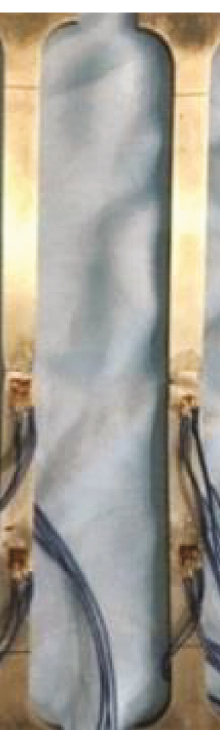
Figure 4: Image of a damaged specimen.